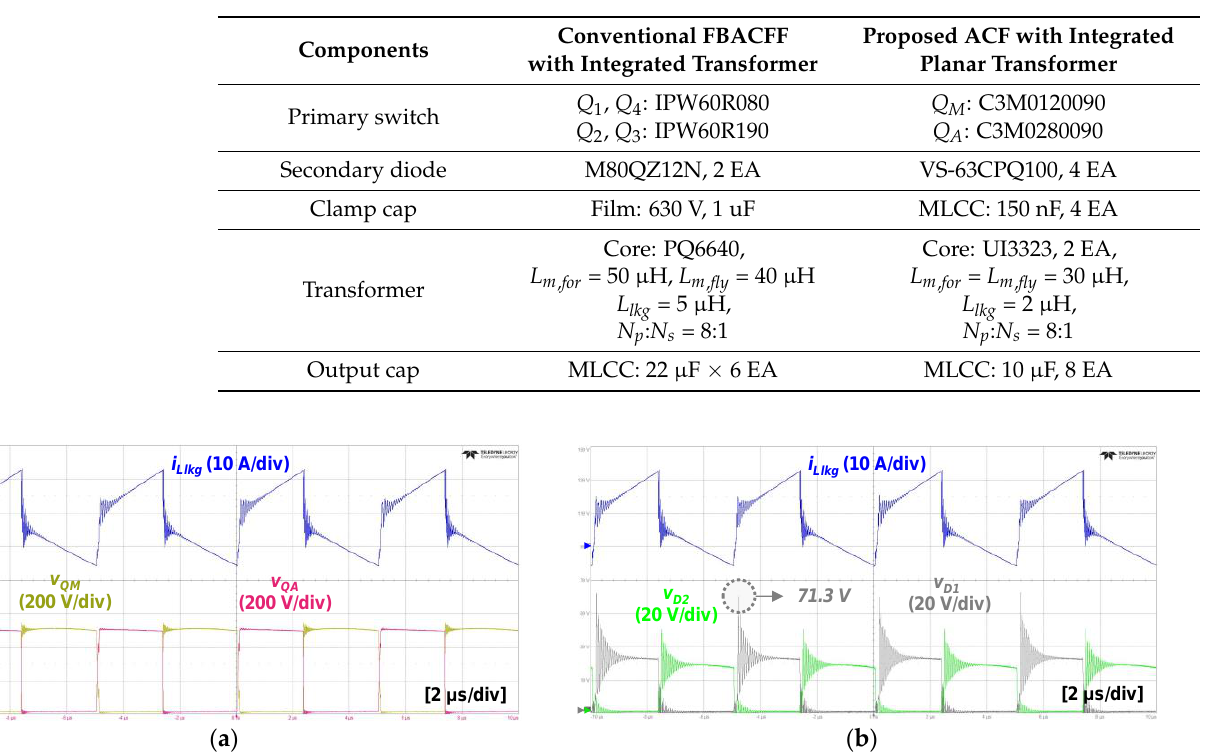
Table 4. Parameters of Prototype Hardware.